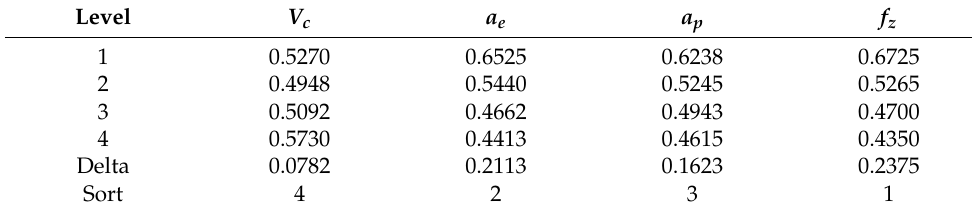
Table 6. The mean response for gray correlation grade γ .